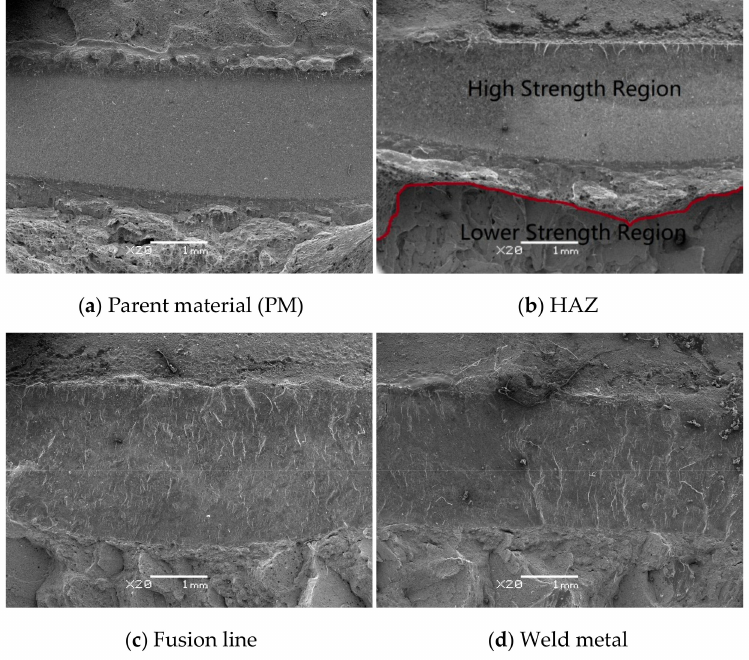
Figure 9. Fracture surfaces after the fracture toughness experiment. ( a ) Parent material (PM); ( b ) HAZ; ( c ) Fusion line; ( d ) Weld metal.